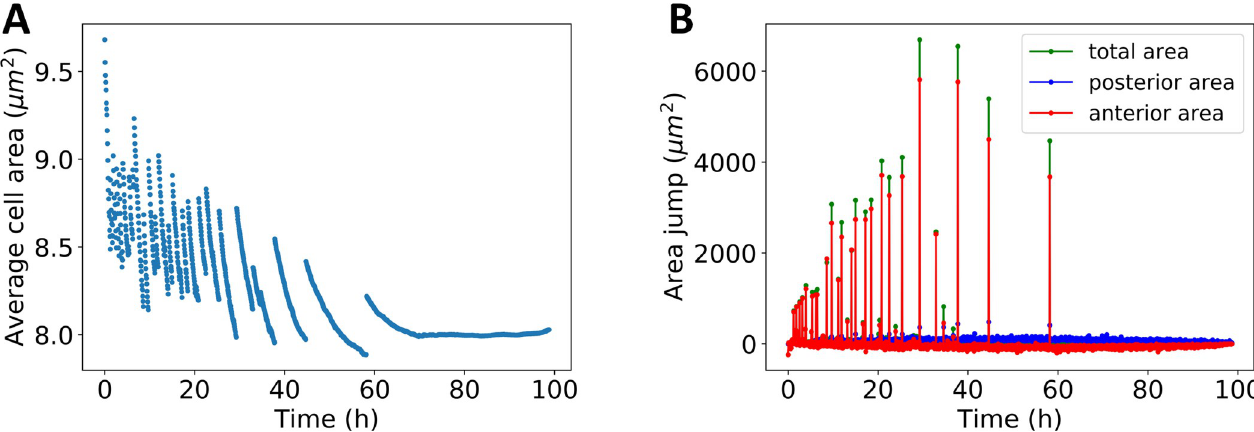
Fig 9. Avalanches in eye disc growth dynamics. A: Time dependence of the average cell area. The avalanches are captured by discontinuous transitions from high cell packing to low. B: Time dependence of tissue area jumps for total, anterior and posterior area, marked by green, red and blue respectively. The avalanches lead to tissue area discontinuities, with the majority occurring in the